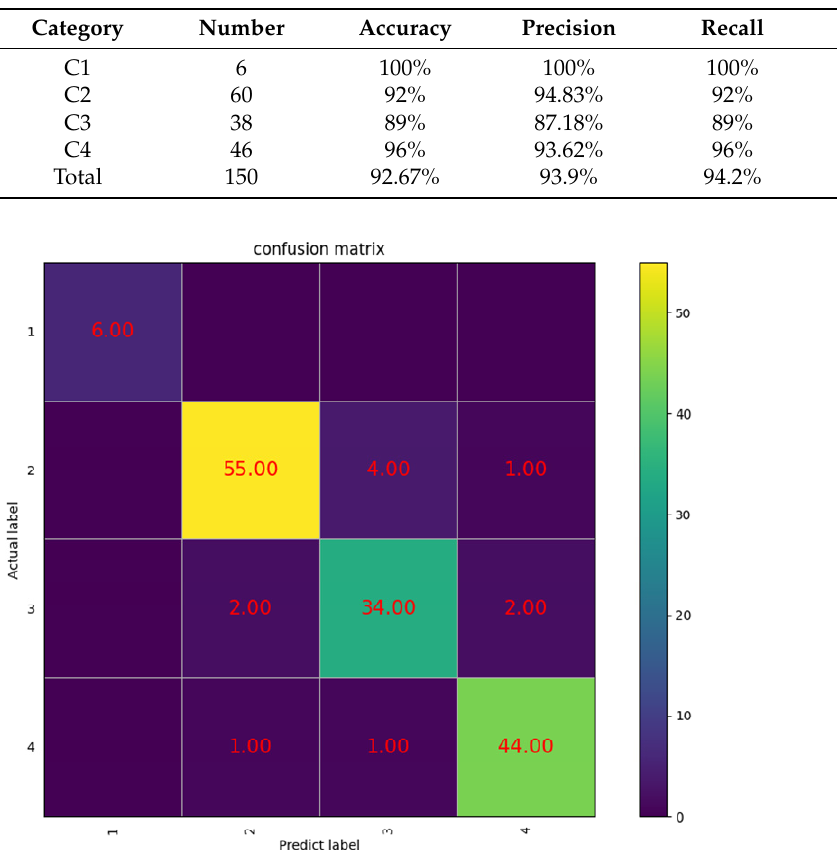
Table 4. Experimental results of DSFF-DenseNet-DT.